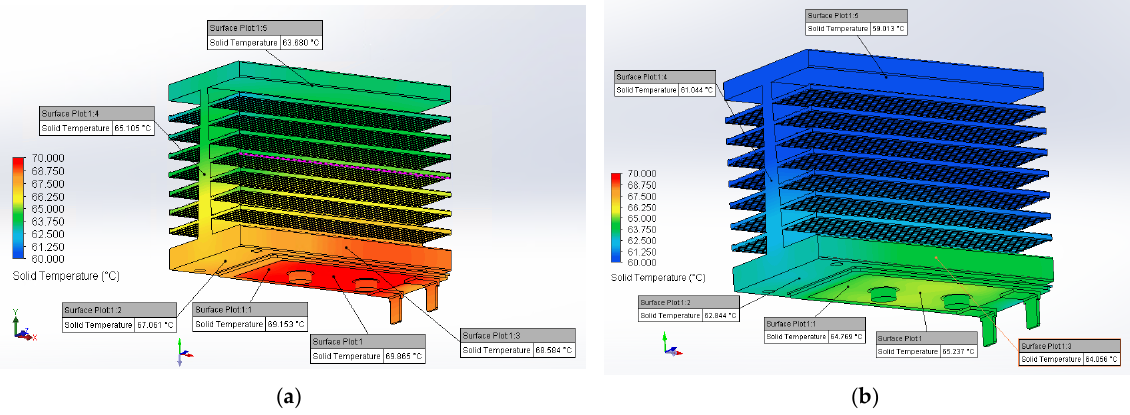
Figure 17. ( a ) Temperature plot of Setup 3 simulation; ( b ) Temperature plot of Setup 4 simulation. For an air velocity comparison between the fins, which can be seen in Figure 18, the same position for the section view was used as before. It can be also seen that gravity has an influence on air velocity.